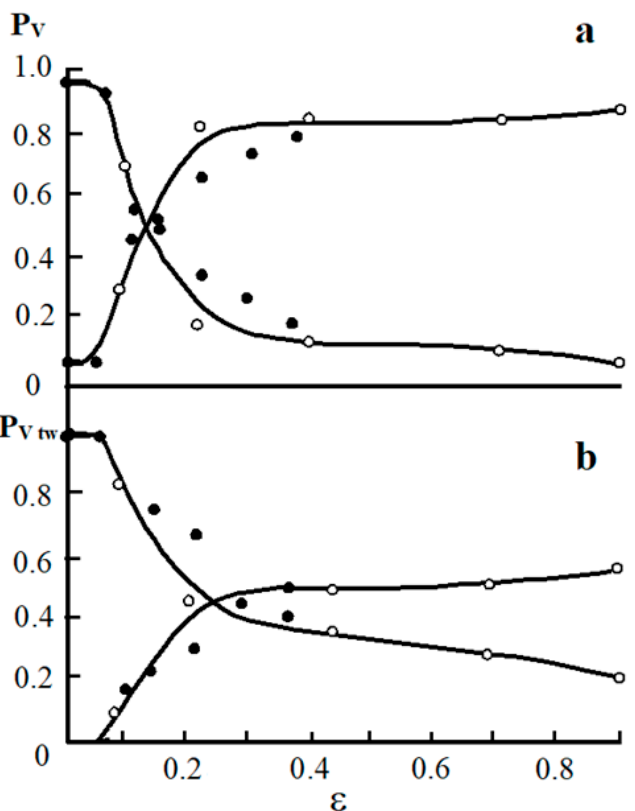
Figure 6. Twin area fraction of material covered by sliding ( a ) and twinning ( b ) depending on the degree of deformation: •—tensile deformation, ⸰ —rolling deformation.